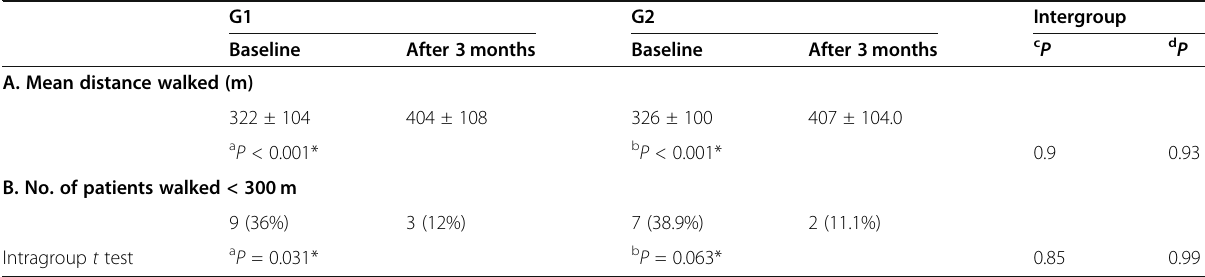
Table 3 Intra- versus intergroup comparison of 6 min walk test at the baseline versus at 3 months follow-up for the two groups G1